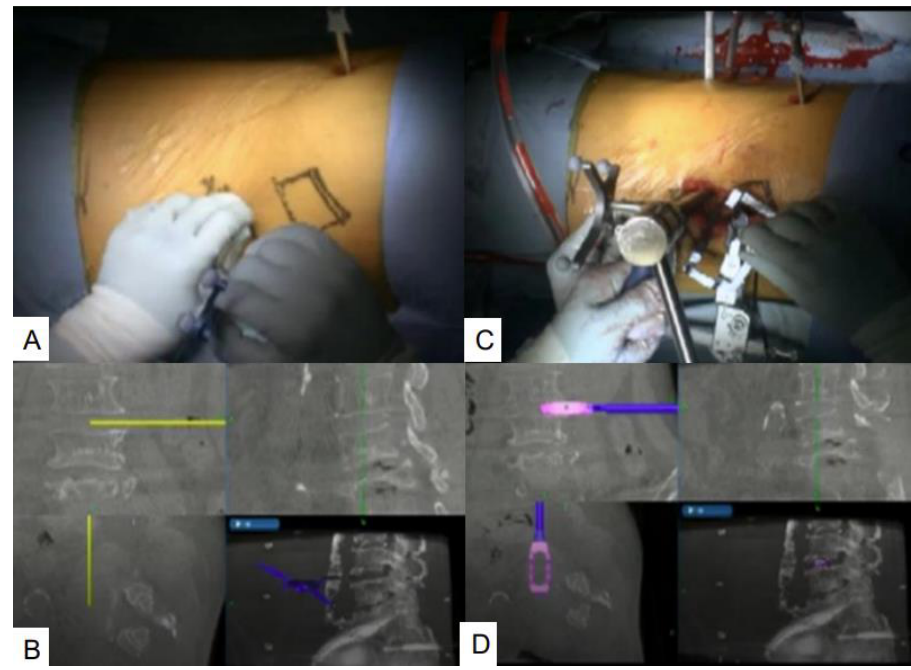
Figure 6. Navigated pointer and OLIF cage. ( A , B ) Skin incision with a navigated pointer; ( C , D ) Navigated OLIF cage.